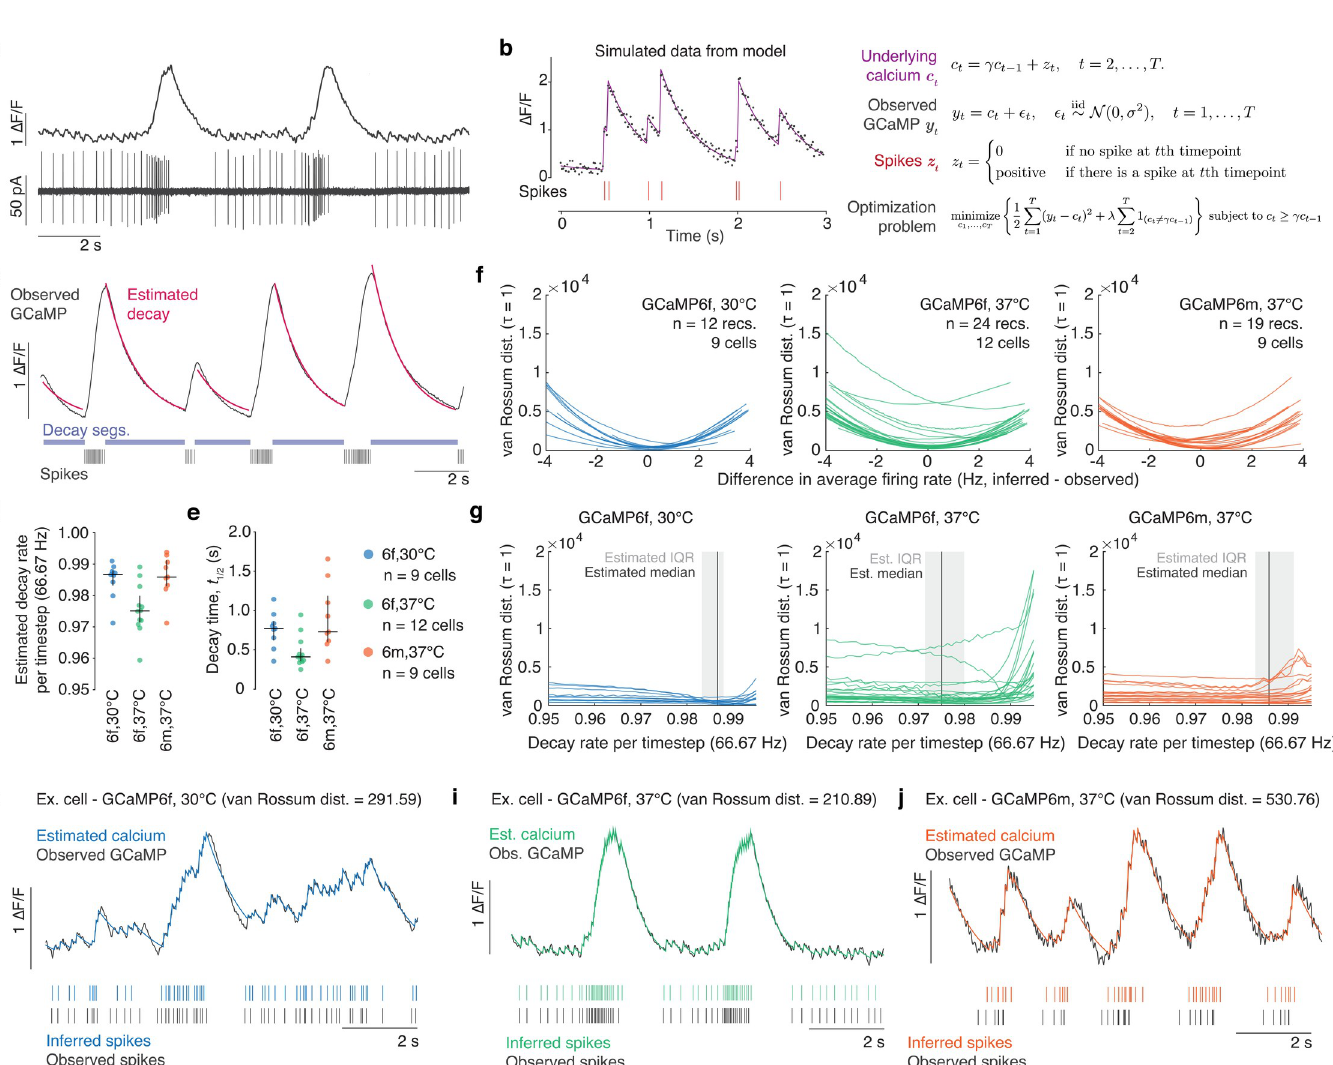
PLOS ONE | https://doi.org/10.1371/journal.pone.0252345 June 4, 2021 3 /